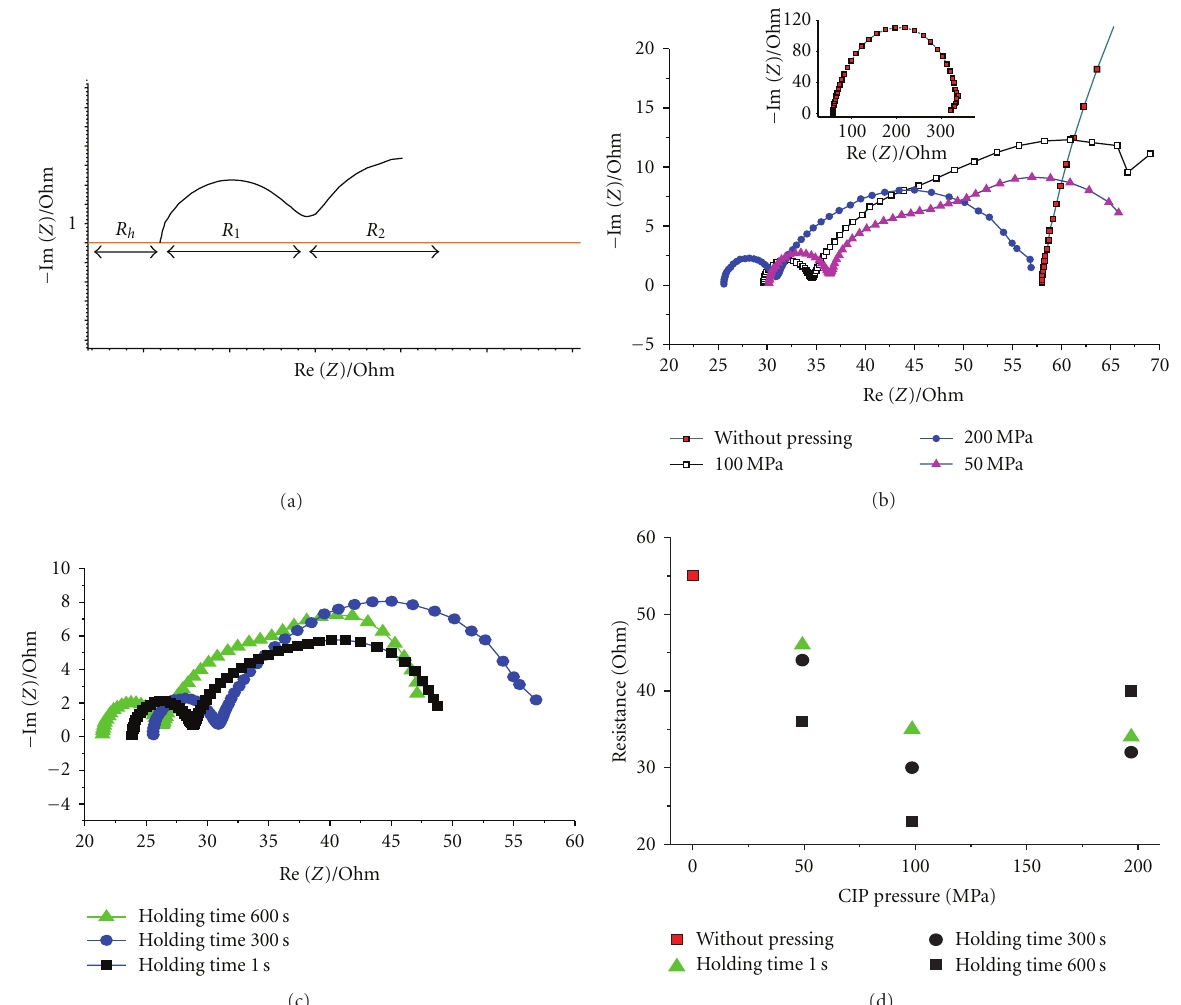
Figure 5: Nyquist impedance results of DSCs after various CIP processes. (a) Schematic diagram of the –Im( Z ) versus Re( Z ) curve; (b) Nyquist impedance results of samples without CIP and with CIP at di ff erent pressures for 300 s; (c) Nyquist impedance results of samples with the same CIP pressure of 200 MPa but di ff erent holding time; (d) calculated overall internal resistance of TiO 2 films after various CIP pressing. The overall internal resistance of the sample without pressing is 55